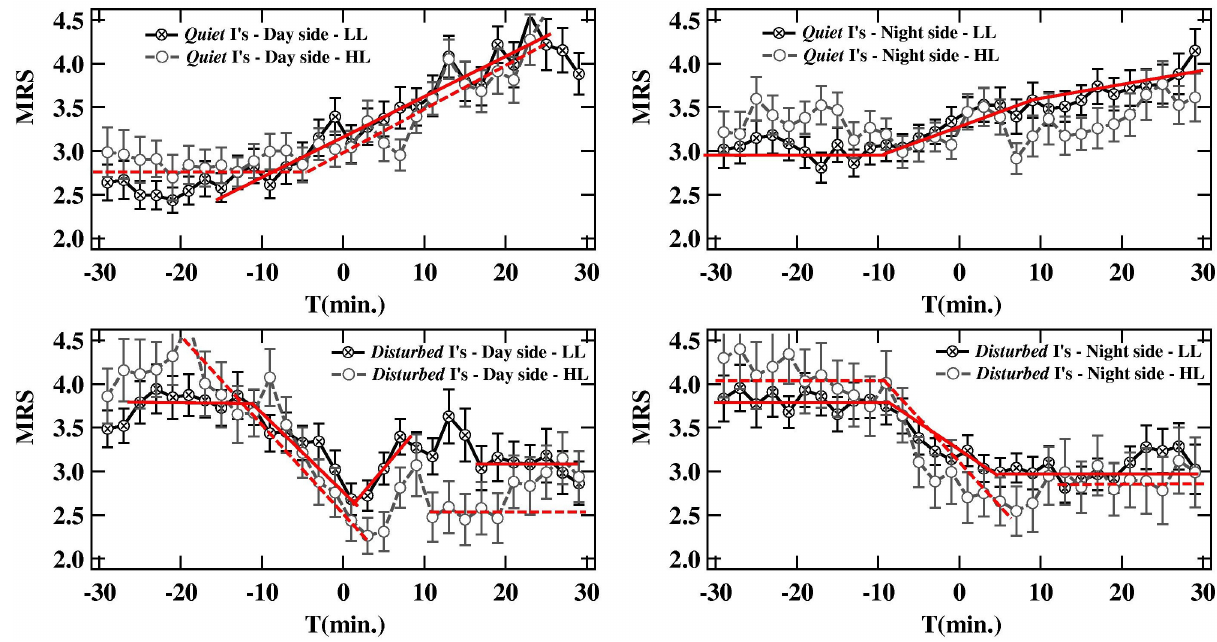
Fig. 9. Left side – Upper panel: plot of MRS vs. time for dayside (06:00 − 18:00 MLT) Quiet Is: the solid line refers to Low Latitude (LL, 60 ◦ − 70 ◦ 3 ), while the dashed line refers to High Latitude (HL, 70 ◦ − 80 ◦ 3 ). Left side – Lower panel: the same as for the upper panel, but for Disturbed Is. Right side – Upper panel: plot of MRS vs. time for nightside (18:00 − 06:00 MLT) Quiet Is: the solid line refers to Low Latitude (LL, 60 ◦ − 70 ◦ 3 ), while the dashed line refers to High Latitude (HL, 70 ◦ − 80 ◦ 3 ). Right side – Lower panel: the same as for the upper panel, but for Disturbed Is.